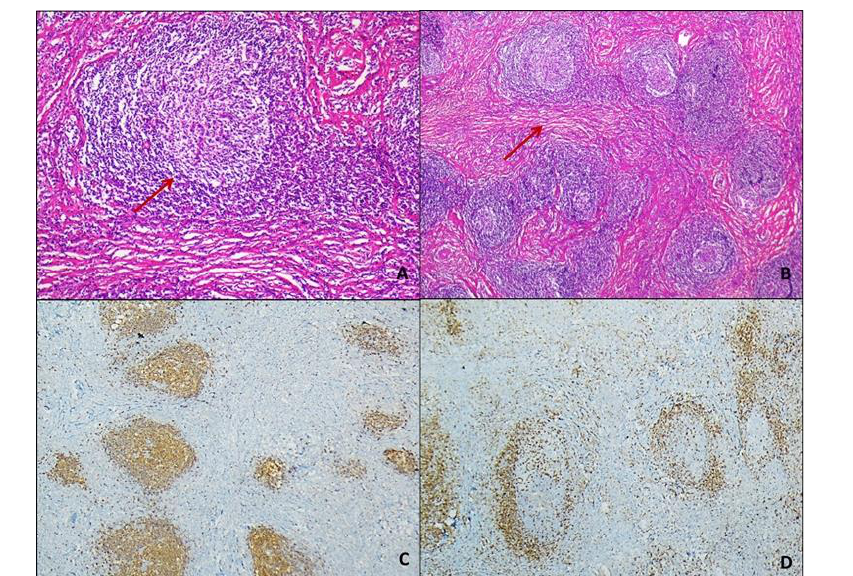
Figure 2. Histopathological features of lung parenchyma. A, B: Lymphoid follicles with reactive germinal centers (red arrow) and, B, C: Interfollicular fibrosis with polyclonal plasma cells